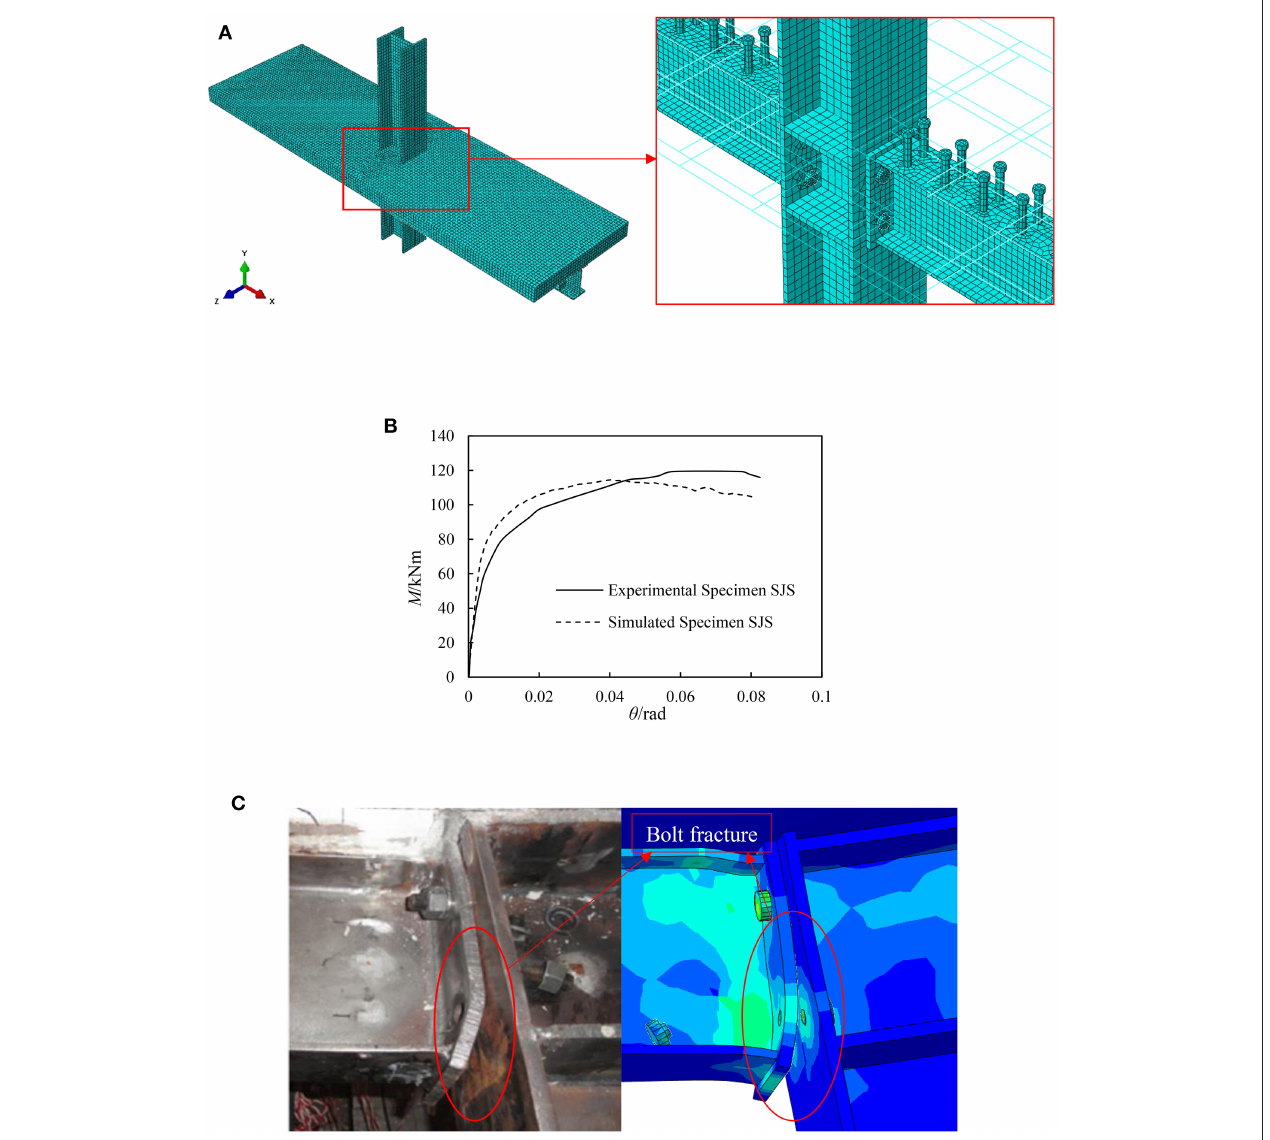
FIGURE 7 | Comparison of simulated and experimental Specimen SJS. (A) FE model of Specimen SJS. (B) Bending moment-rotation angle curve comparison. (C) Failure mode